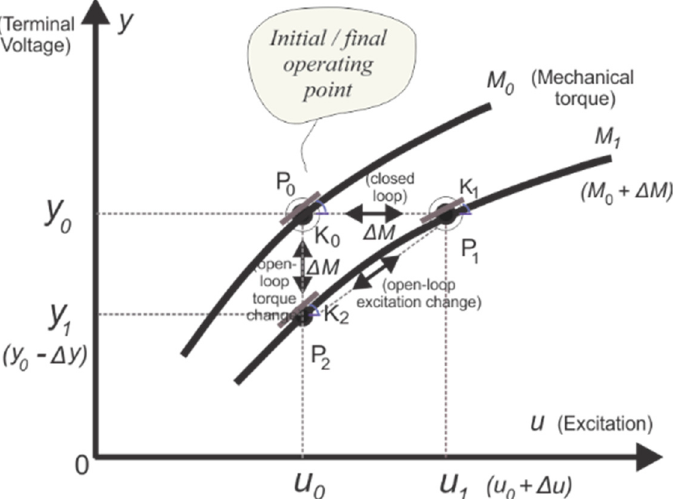
Figure 4. Operational characteristics of induction generator.